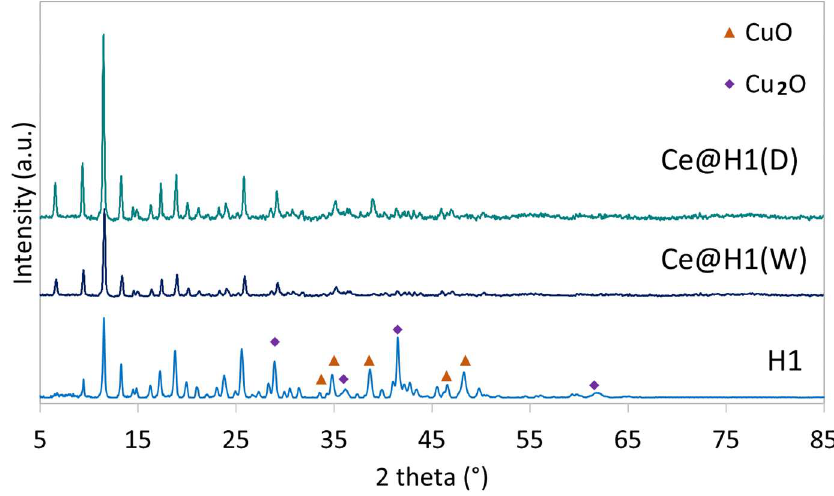
Figure 12. XRD for HKUST-1 and Ce@HKUST-1 catalysts after tests of CO oxidation.